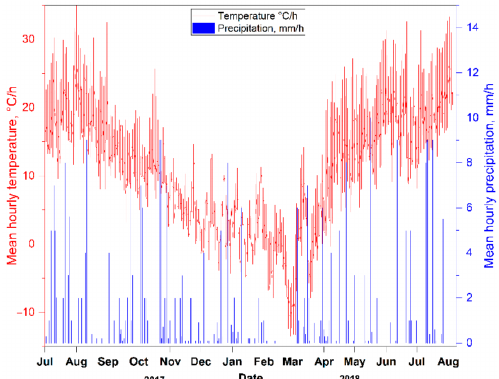
Figure 1. Monthly trends of the air temperature and precipitation observed at a meteorological station located at the Copernicus Airport Wroclaw from July 2017–August